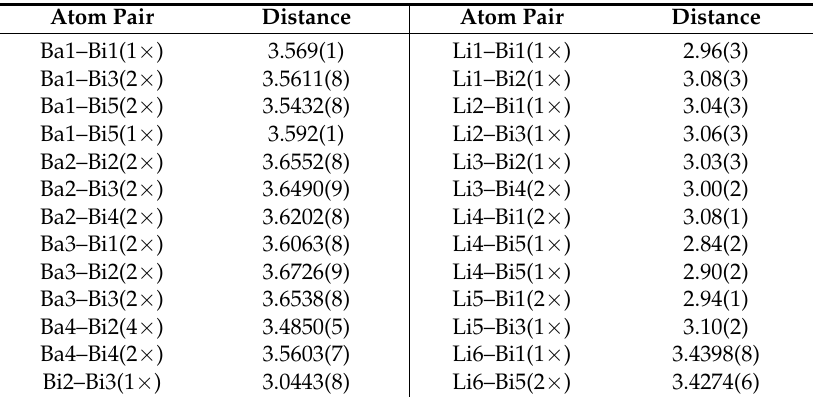
Figure 2. ( a ) Polyhedral representation of the crystal structure of Ba 7 Li 11 Bi 10 , viewed down the crystallographic b -axis. Color codes of the atoms are the same as in Figure 1. ( b ) Ball-and-stick representation of the same structure in the same projection. The unit cell is outlined. Table 6. Selected distances (Å) in Ba 7 Li 11 Bi 10 .